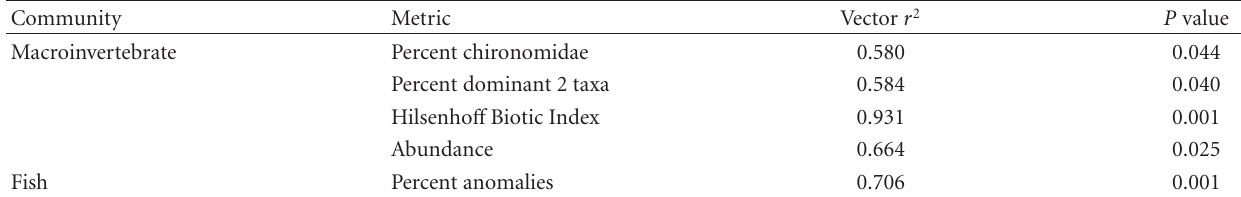
Table 1: Significant Pearson’s correlation coe ffi cients and associated permutational P values (1000 randomizations) for relations between fish Daniels et al. [19] and macroinvertebrate indices of biotic integrity metrics and nonmetric multidimensional scaling (NMDS) ordination for the communities sampled during the summers of 2009 and 2010 from the Cacapon River, WVa, USA. Community Metric Vector r 2 P value Macroinvertebrate Percent chironomidae 0.580 0.044 Percent dominant 2 taxa 0.584 0.040 Hilsenho ff Biotic Index 0.931 0.001 Abundance 0.664 0.025 Fish Percent anomalies 0.706